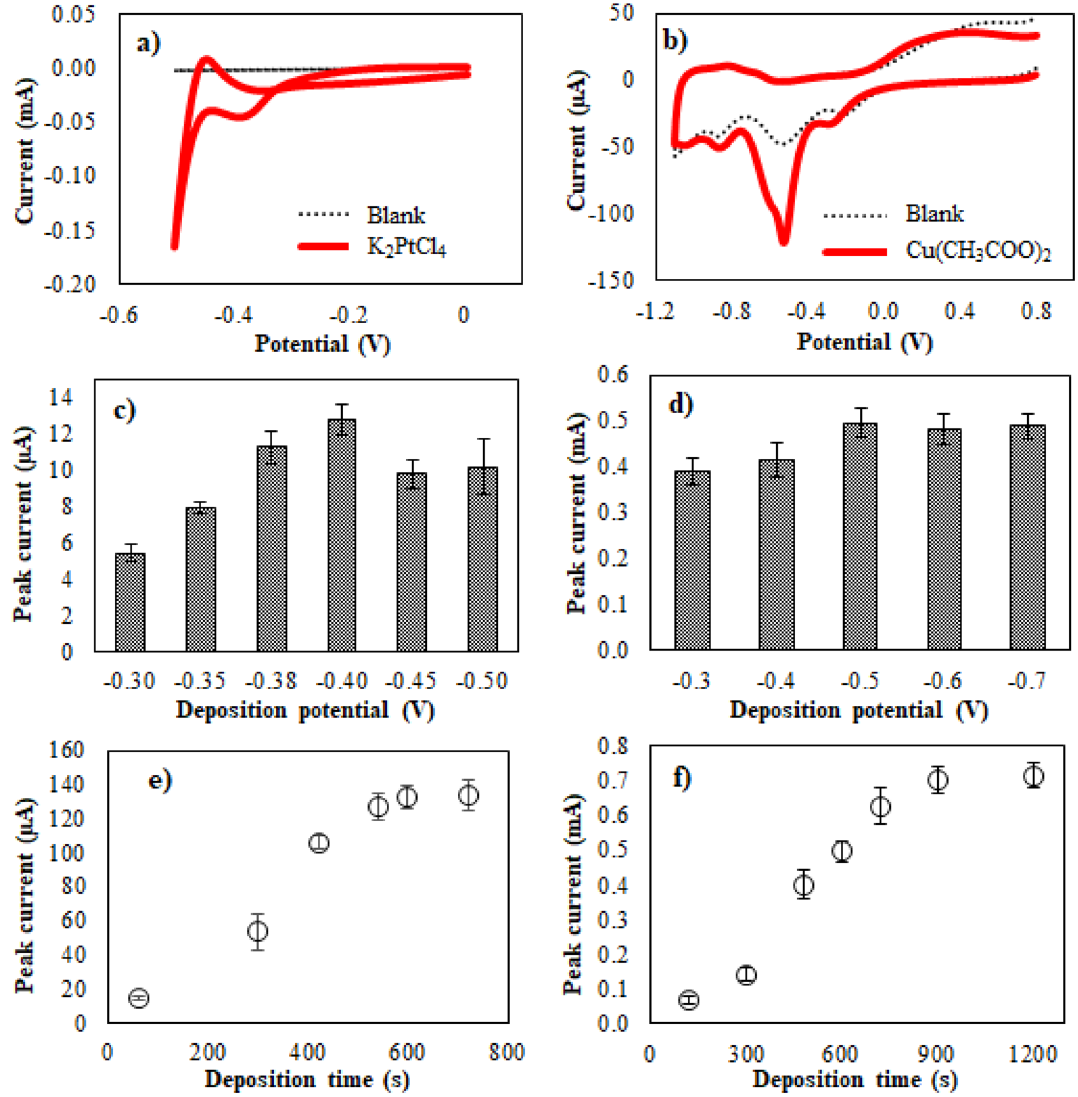
Figure 5. Cyclic voltammograms of ( a ) Pt reduction on BDD electrode, and ( b ) Cu reduction on Pt/BDD electrode; optimization of deposition potential of ( c ) Pt and ( d ) Cu; optimization of deposition time of ( e ) Pt and ( f )